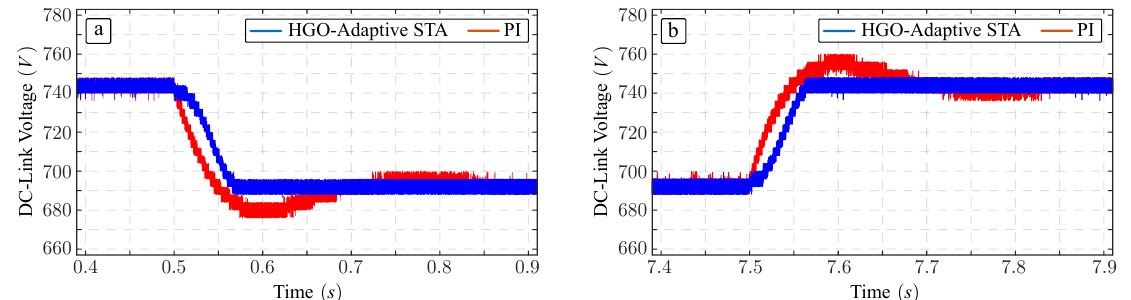
Figure 7. NPC dc-link dynamic under a voltage step. ( a ) A voltage step from 750 V to 700 V; ( b ) A voltage step from 700 V to 750